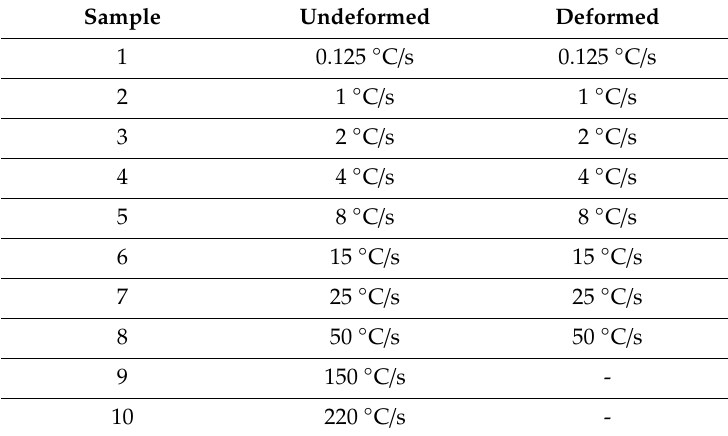
Figure 2. Thermal cycles of dilatometric analysis for non-deformed and deformed austenite; A T —austenitizing temperature, A t —austenitizing time. Table 1. Cooling rates selected for the dilatometric analysis.